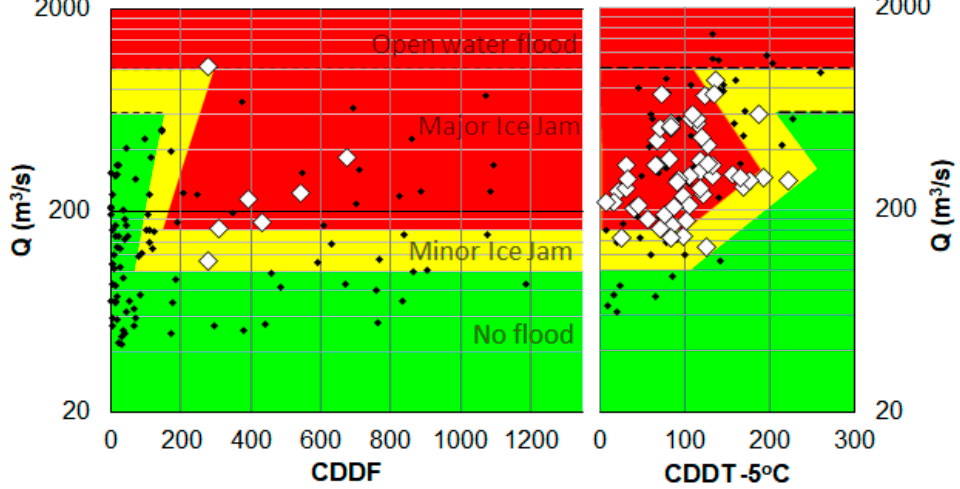
Figure 2. River-ice breakup model for the winter ( left ) and spring ( right ) periods for the Chaudière River. White diamonds are confirmed ice-jam events and black dots are peak flows associated with significant runoff events between 1972 and 2000.